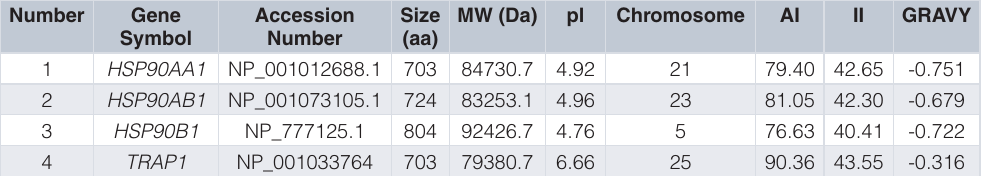
Table 4. Biochemical characterization of the bovine heat shock protein 90 protein genes.